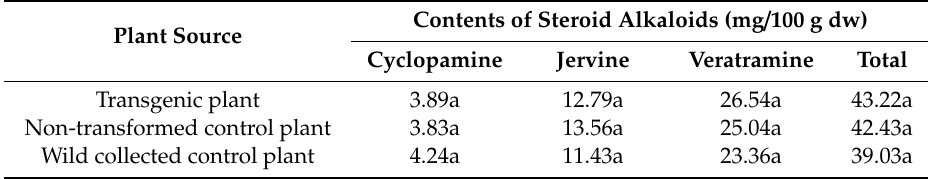
Table 1. Contents of steroid alkaloids in di ff erent plant sources.